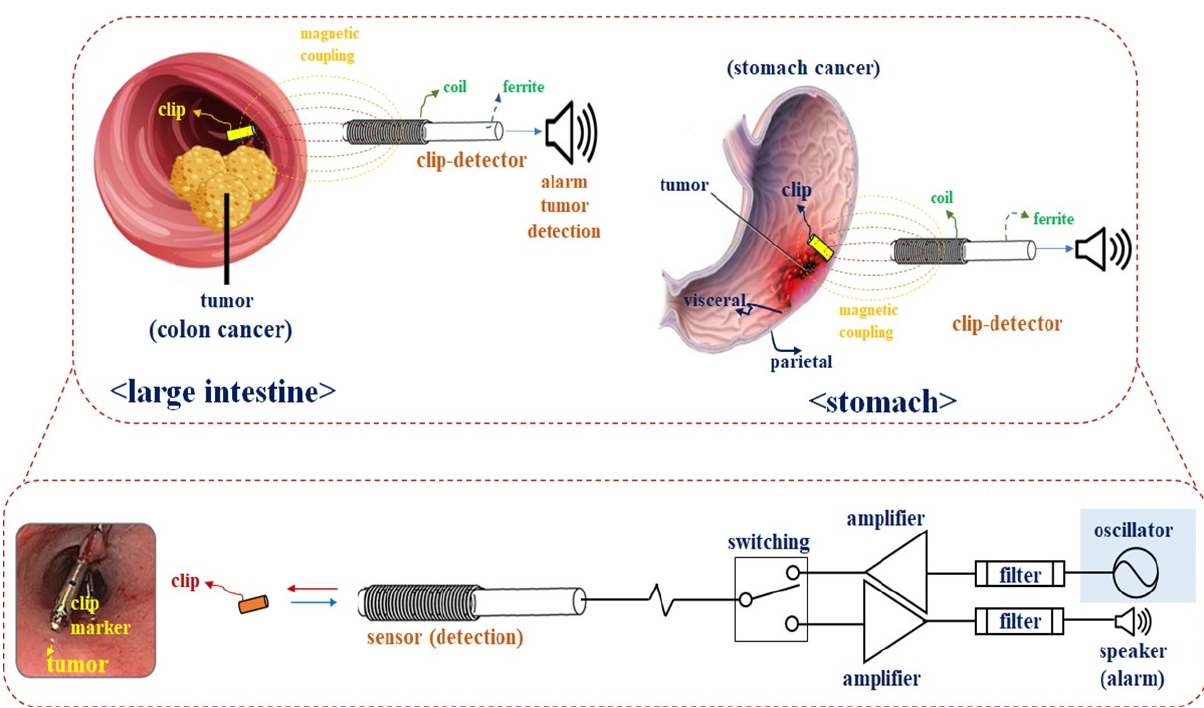
Figure 1. Oscillator and sensor for tumor tracking. Table 1. Resonator Q L for tissue marker applications.